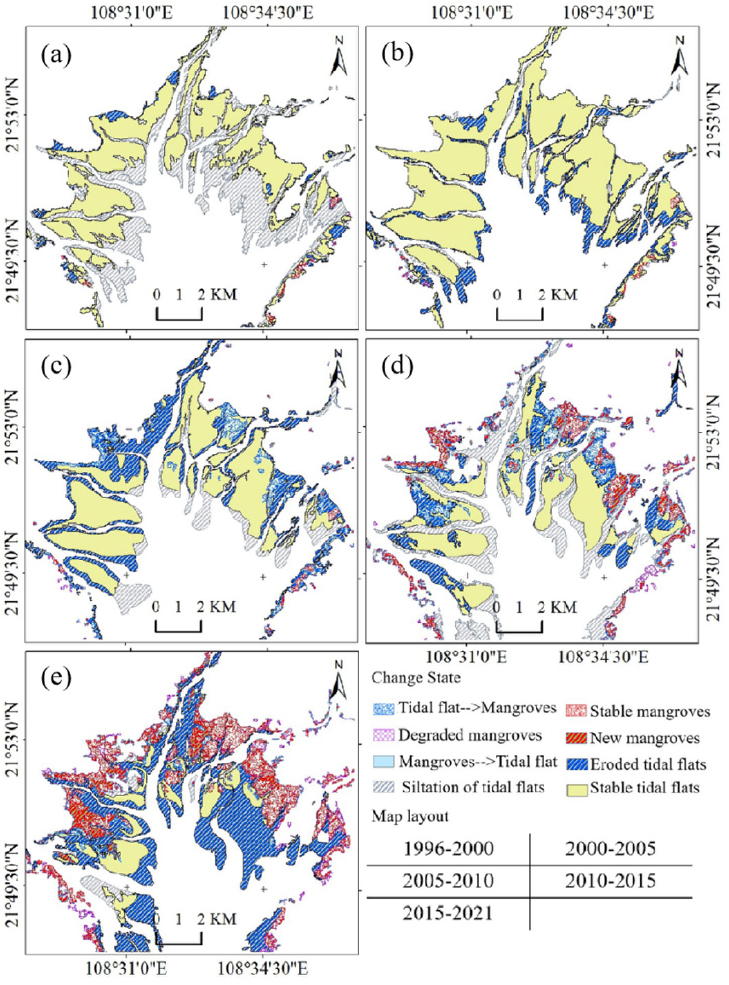
Figure 22. Tidal sequence change and centroid transfer of mangrove tidal fl at in Pearl bay. ( a ) Interclass changes of mangroves and tidal fl ats in Pearl bay from 1996 to 2000. ( b ) Interclass changes of mangroves and tidal fl ats in Pearl bay from 2000 to 2005. ( c ) Interclass changes of mangroves and tidal fl ats in Pearl bay from 2005 to 2010. ( d ) Interclass changes of mangroves and tidal fl ats in Pearl bay from 2010 to 2015. ( e ) Interclass changes of mangroves and tidal fl ats in Pearl bay from 2015 to 2021.